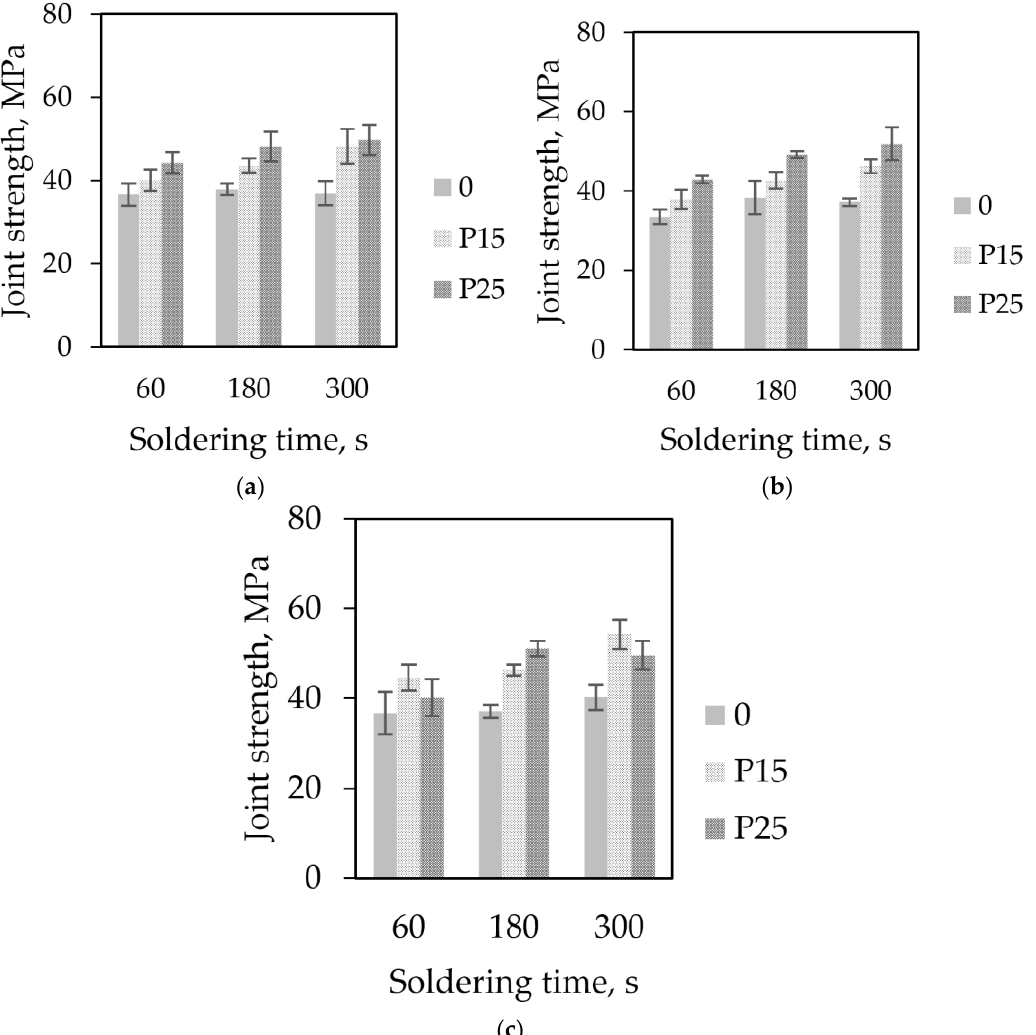
Figure 7. Effect of soldering time and porosity on joint strength at soldering temperature of ( a ) 267 °C, ( b ) 287 °C, and ( c ) 307 °C.